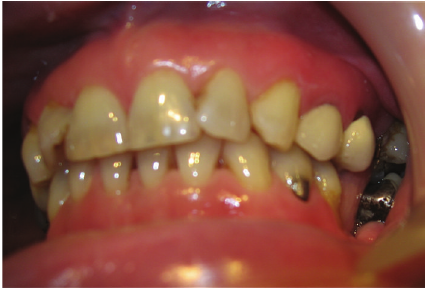
Figure 7: UL4 porcelain